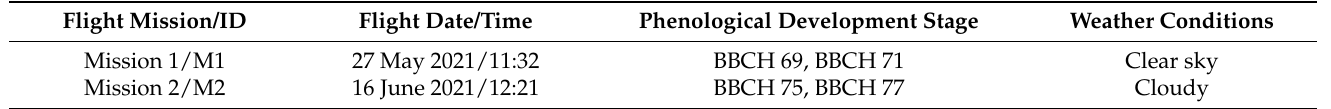
Table 3. UAV flight missions’ dates, corresponding phenological development stage of the studied genotypes of winter durum wheat, and weather condition during the flight.